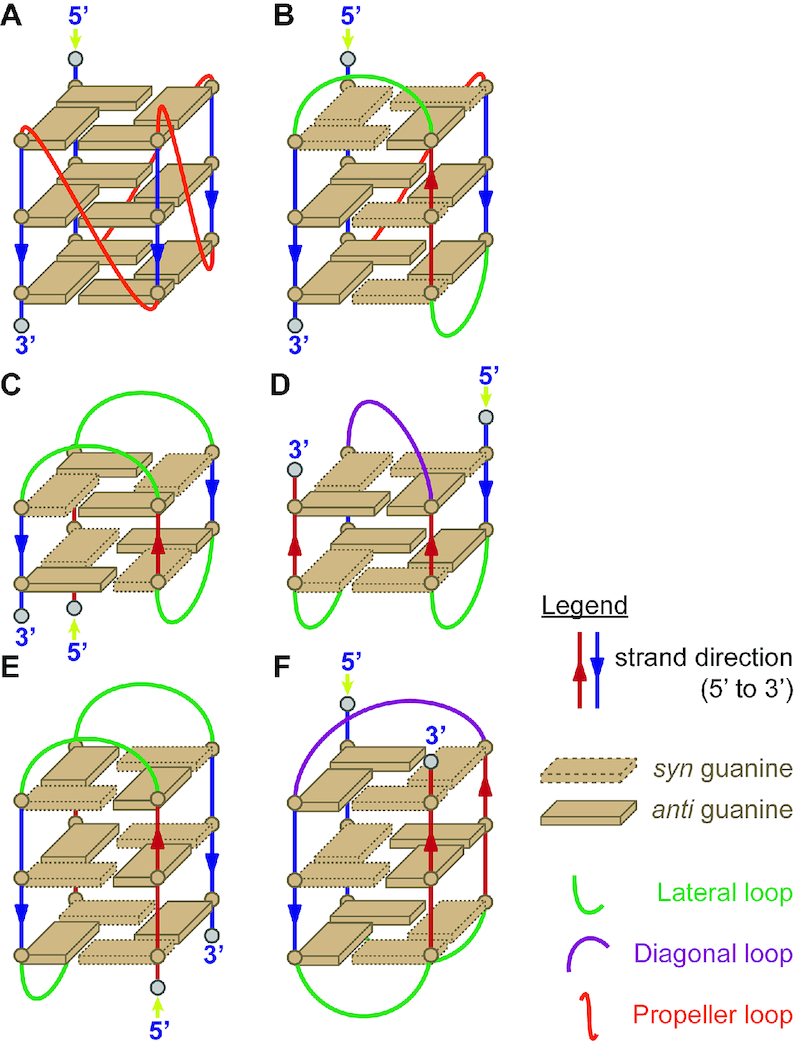
Schematic representation of different G4 topologies. (A) Parallel (type I stacking), (B) Hybrid (type II stacking), (C) Antiparallel 2-quartet (type III stacking with chair conformation), (D) Antiparallel 2-quartet (type III stacking with basket conformation), (E) Antiparallel 3-quartet (type II stacking with chair conformation), (F) Antiparallel 3-quartet (type III stacking with basket conformation, not represented in our database).